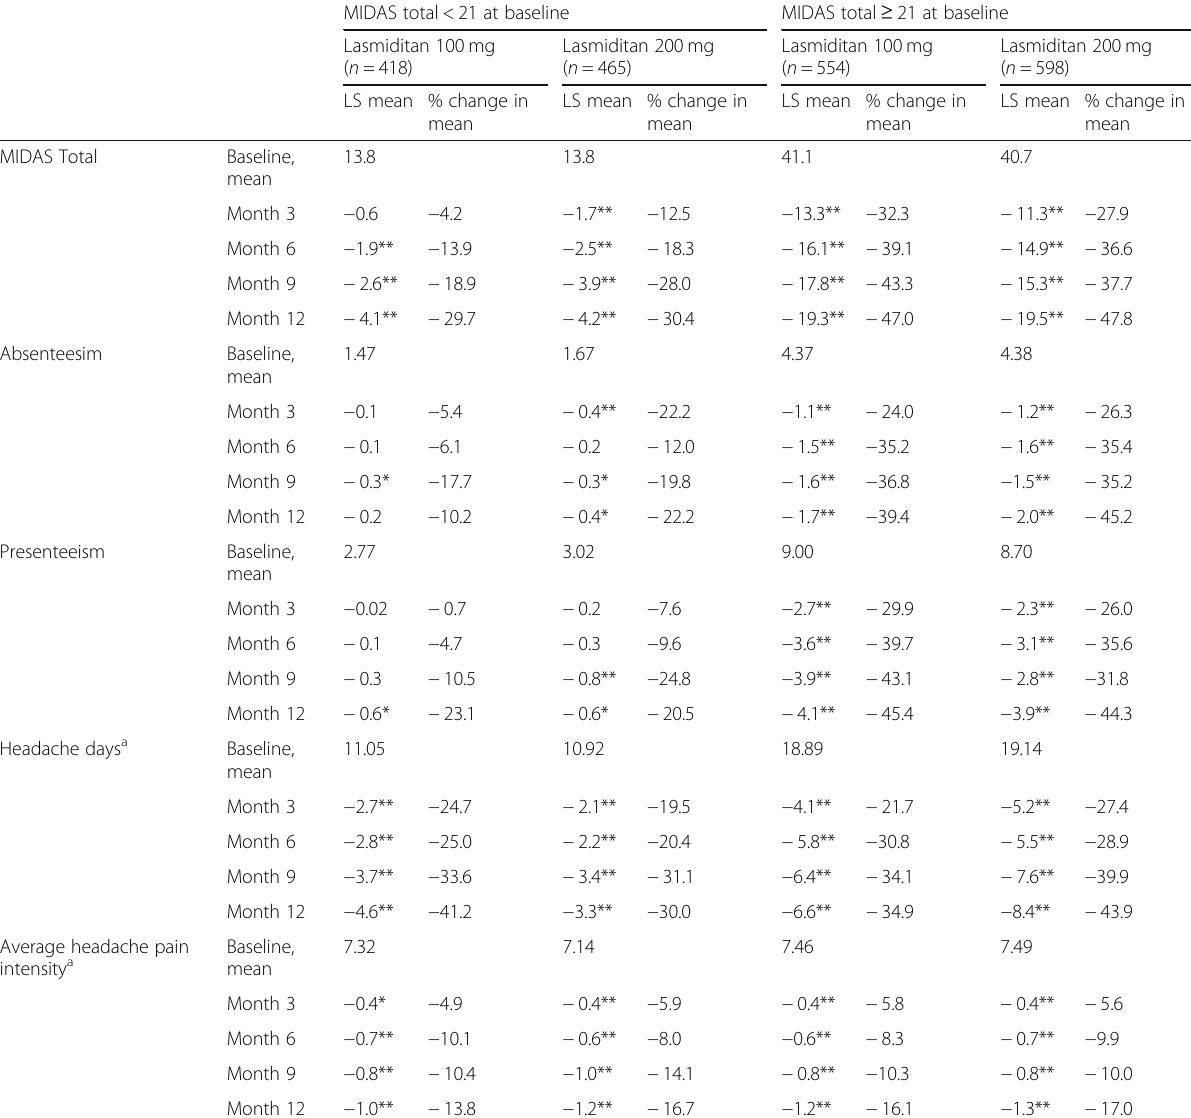
Table 5 Change from baseline in MIDAS response by baseline MIDAS disability severity (<21 vs. ≥